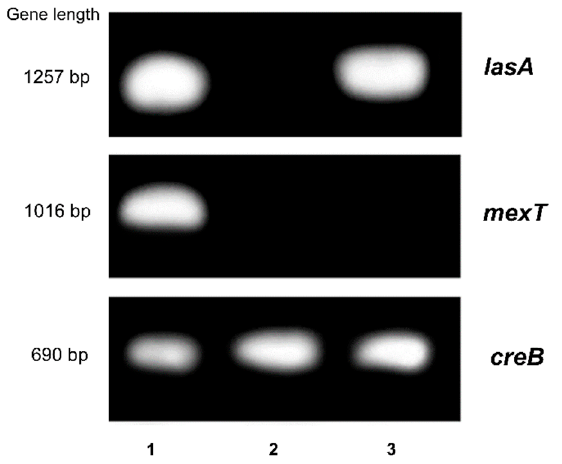
Figure 5. Electrophoresis analysis of lasA and mexT genes in Pseudomonas aeruginosa ATCC 27853. SE: ethanol extract obtained by Soxhlet; MaE: ethanol extract obtained by maceration. PCR products were analyzed by agarose gel electrophoresis (1%) stained with GelRed and using a Tris-borate-EDTA buffer. Gels images of lasA and mexT genes were visualized. Lanes: (1) Control: untreated bacteria, (2) SE treatment, (3) MaE treatment. creB gene was used as internal control.